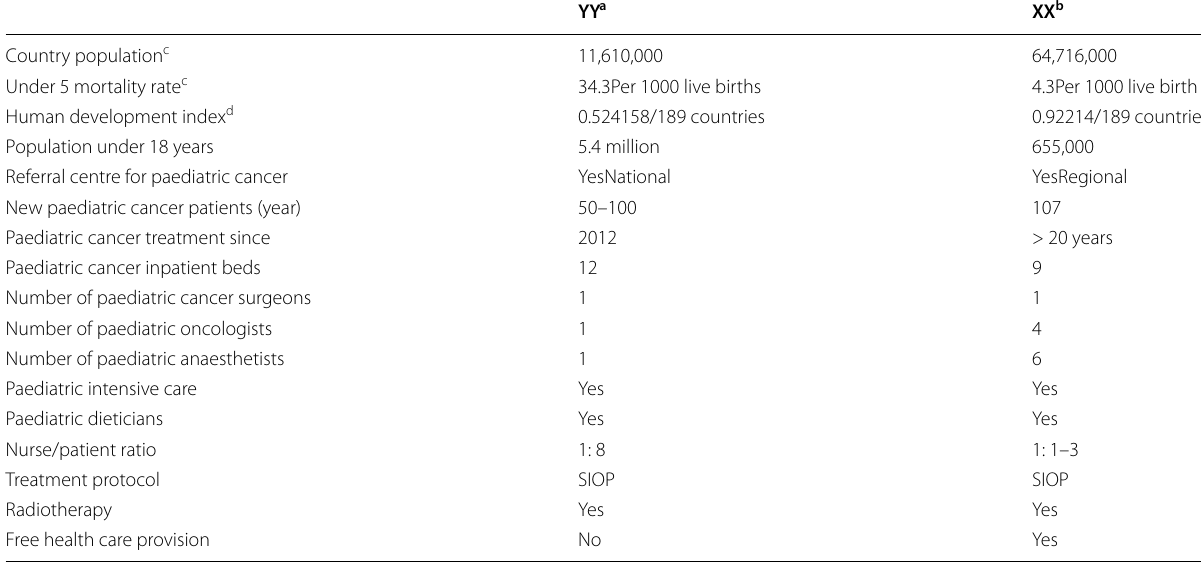
Table 1 Summary of participating centres, available resources and oncology